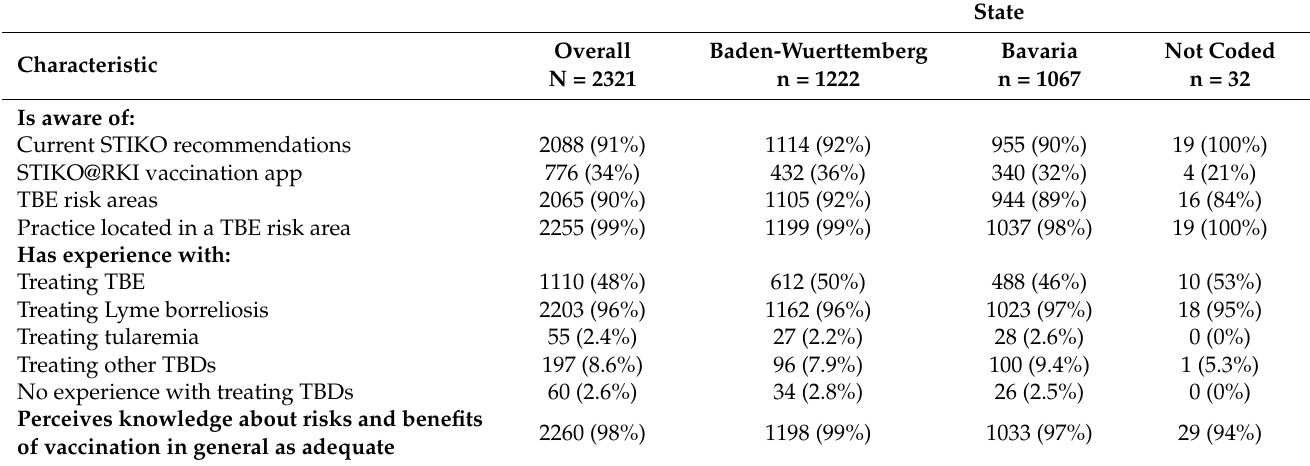
Table 2. Awareness of TBE guidelines and experience with tick-borne diseases among primary care physicians participating in the TBD-Prev survey, Baden-Wuerttemberg and Bavaria,